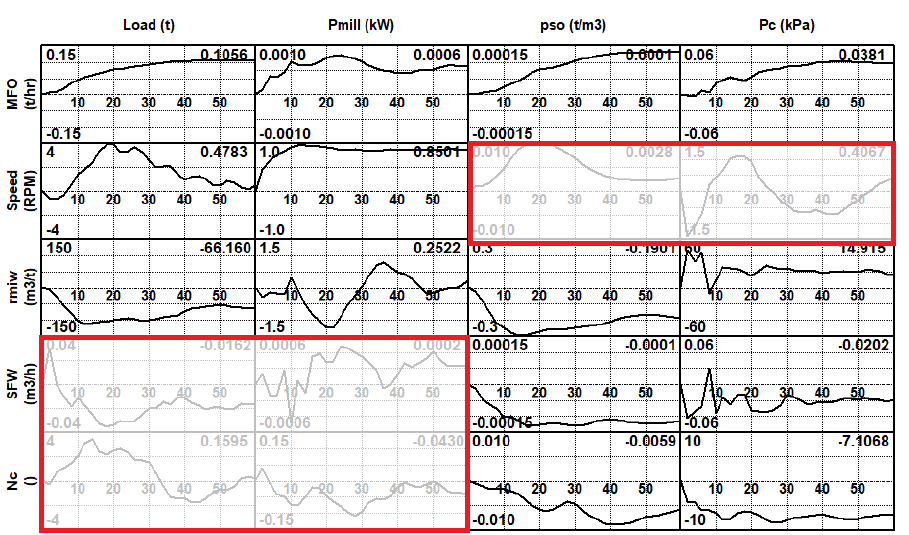
Figure 8. Linear model matrix for DQA